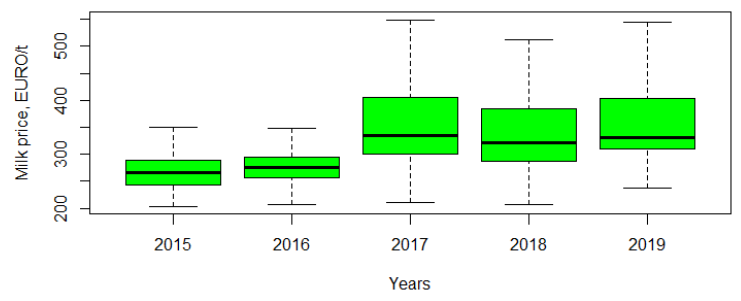
Figure A2. Boxplots for milk prices without outliers (2015–2019).